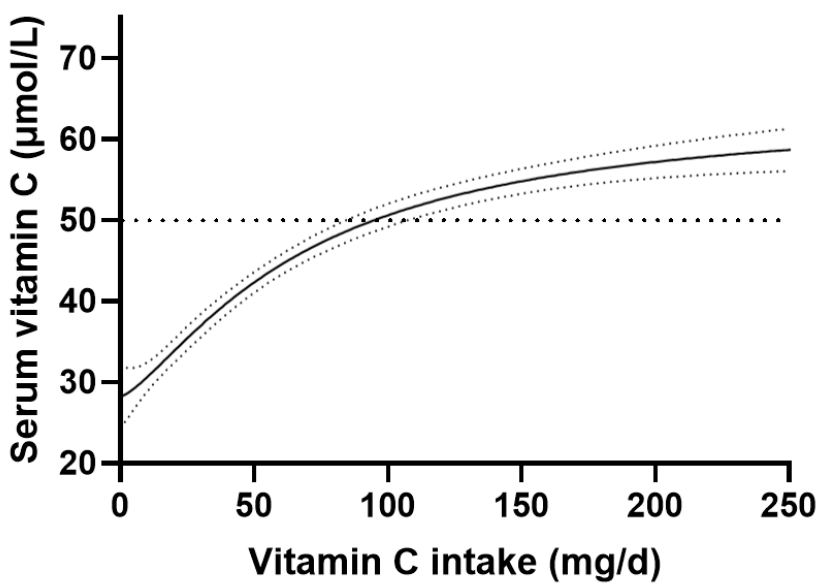
Figure 1. Vitamin C dose-concentration relationship of the total cohort ( n = 2828). Sigmoidal (four parameter logistic) curve was fitted to the dose-concentration data with asymmetrical 95% confidence intervals indicated. Dashed line indicates 50 µmol/L serum vitamin C, which is considered ‘adequate’.